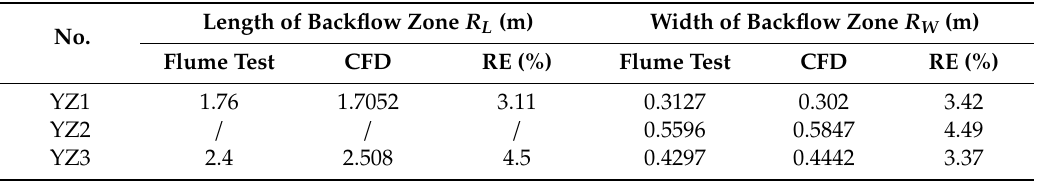
Table 3. Comparison of R L and R W between observed and computed (spur dike 1).